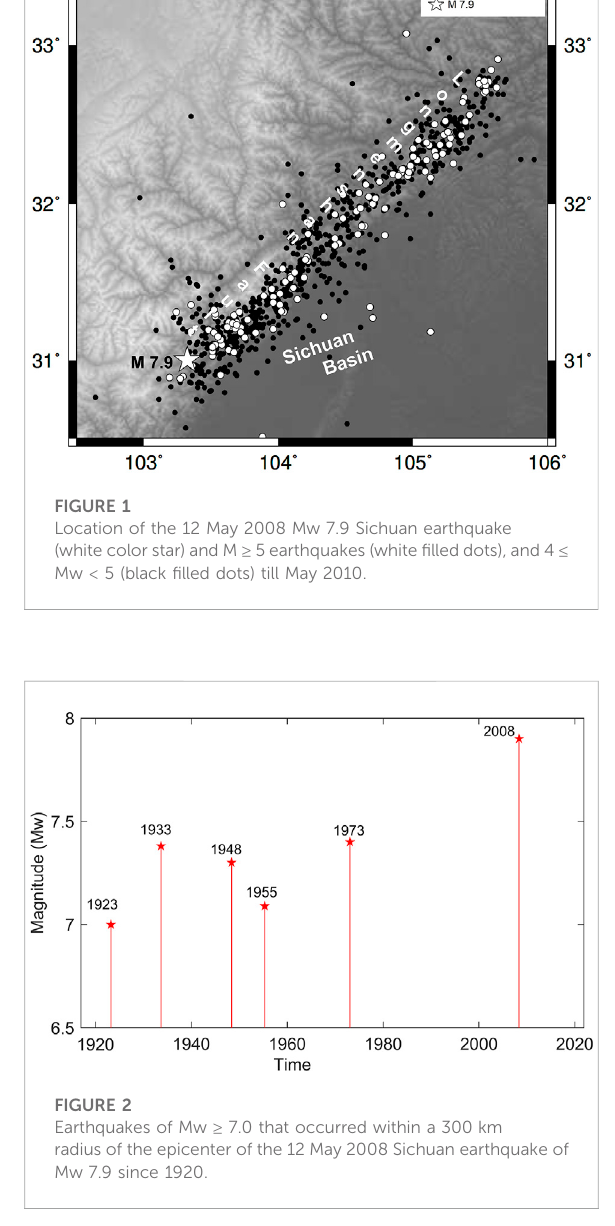
2008 Mw 7.9 Sichuan earthquake, China, that occurred at 06: 28:02 UTC. Figure 1 depicts the location of the epicenter of the Sichuan earthquake and the distribution of Mw 4 and larger earthquakes that have occurred till May 2010 within a radius of 300 km of the epicenter of the Sichuan earthquake. The Sichuan earthquake is located on the northeast-trending Longmenshan fault bordering the Tibetan Plateau on the west and the Sichuan